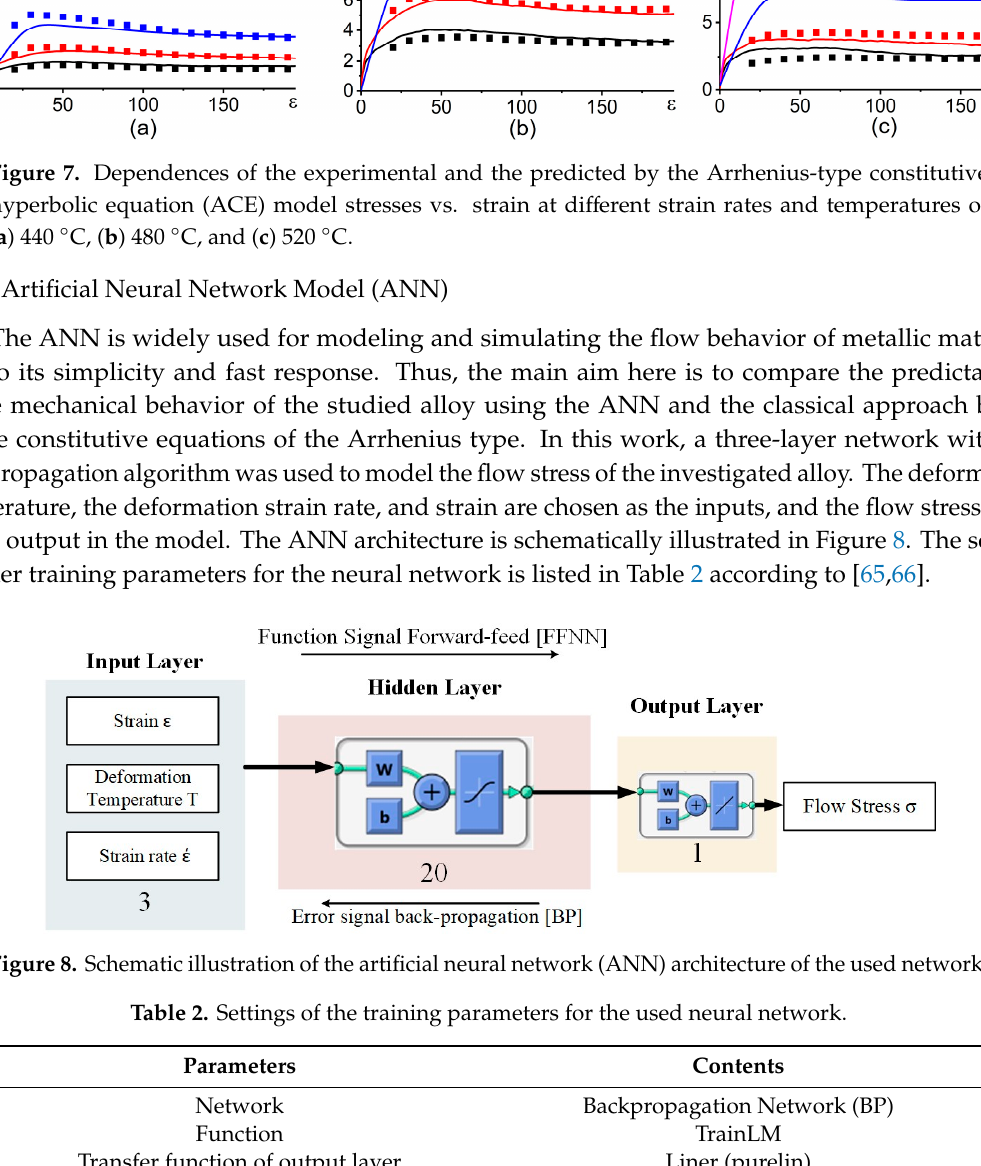
Figure 7. Dependences of the experimental and the predicted by the Arrhenius-type constitutive hyperbolic equation (ACE) model stresses vs. strain at different strain rates and temperatures of ( a ) 440 °C, ( b ) 480 °C, and ( c ) 520 °C.